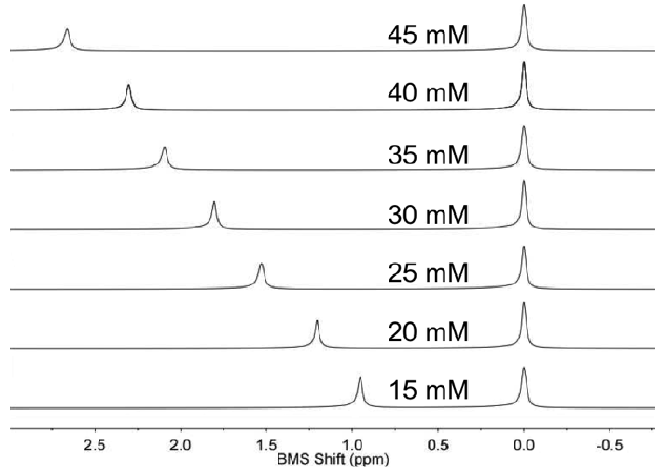
Figure 1. NMR spectra of coaxial samples of Tm(III) ion in nitric acid (left peak) and nitric acid without Tm(III) (right peak) were rapidly acquired and easily analyzed to measure the BMS shift of each